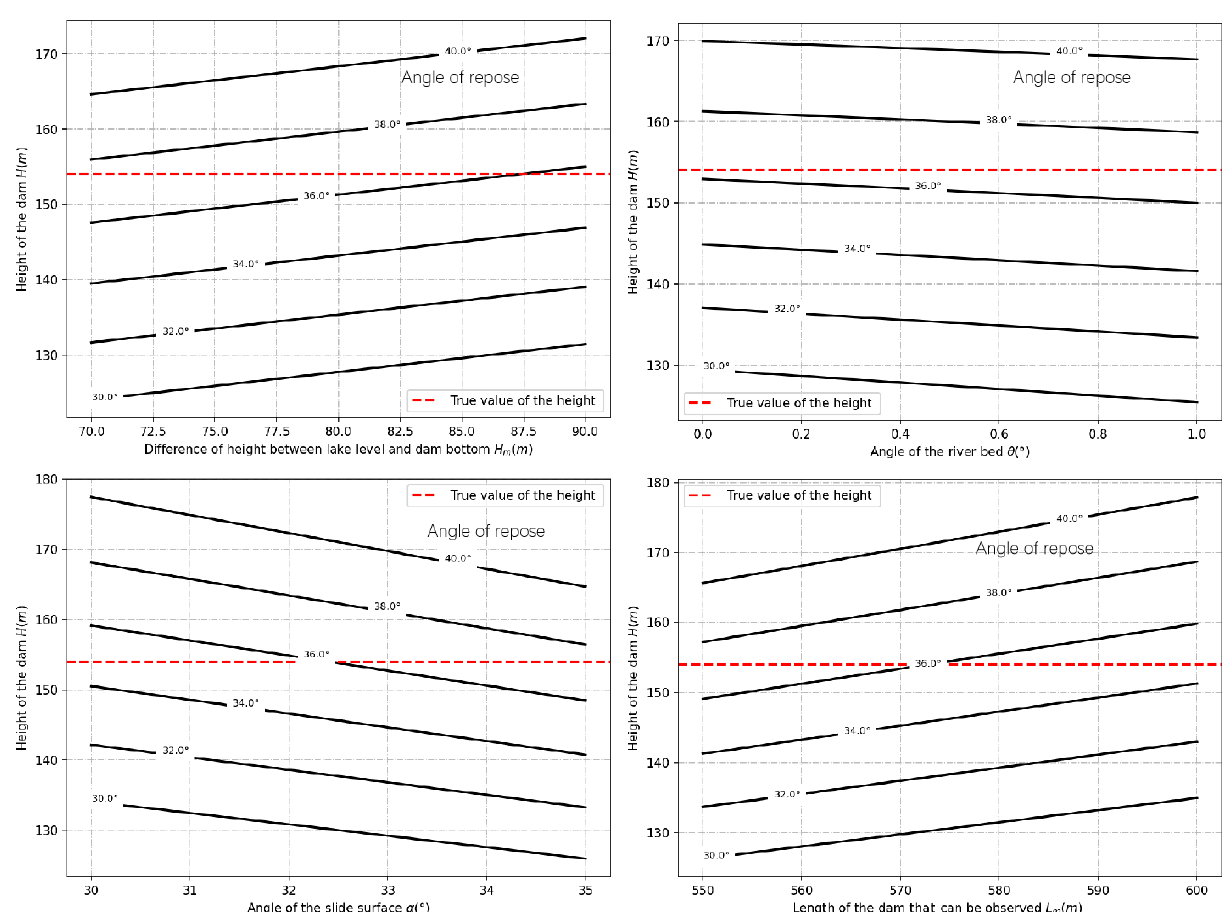
Figure 14. The relationship between the predicted result and each input parameter.